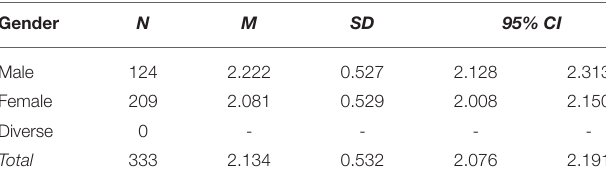
TABLE 3 | Descriptive statistics for the total mean social distance score as function of gender.